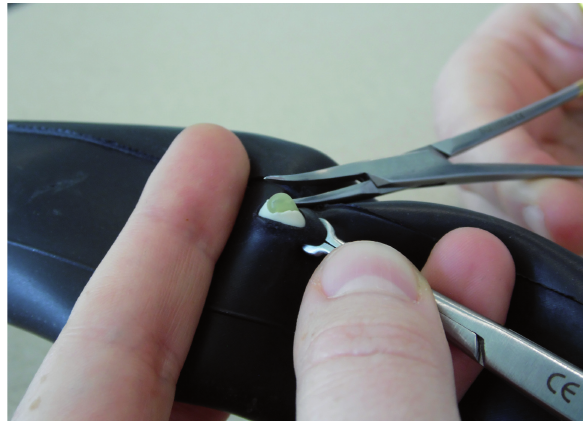
Figure 7 - Hooking the